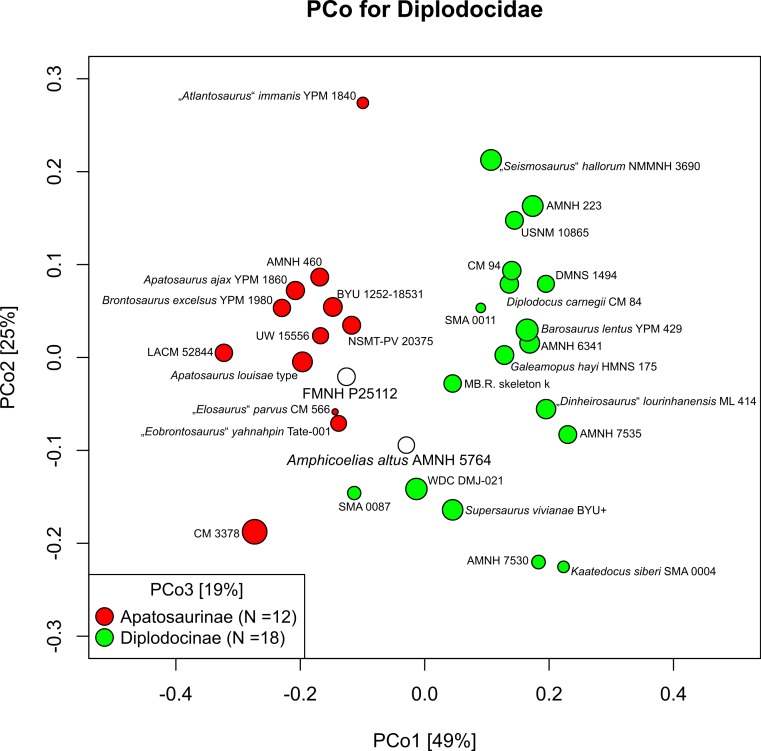
Diplodocid morphospace.First two principal coordinate axes of dissimilarity among Diplodocidae. The third axis is indicated by the size of the points. Note the intermediate, but rather diplodocine position of Amphicoelias altus AMNH 5764 and the rather apatosaurine position of FMNH P25112 (white circles).